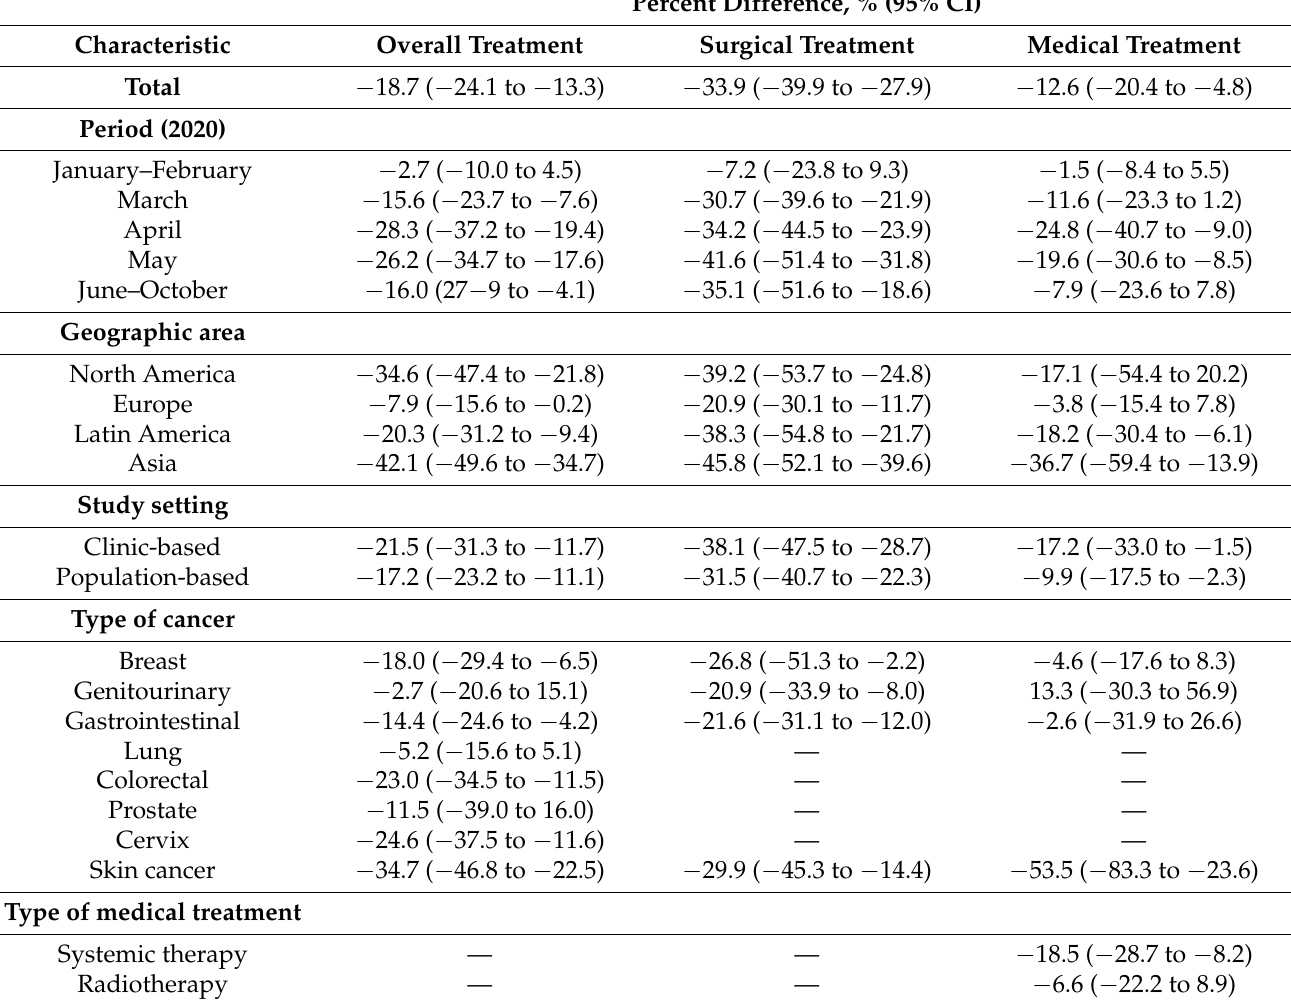
Table 1. Weighted percentage differences between COVID-19 and pre-pandemic periods for overall, surgical, and medical cancer treatments by period, geographic area, study setting, type of cancer, and type of medical